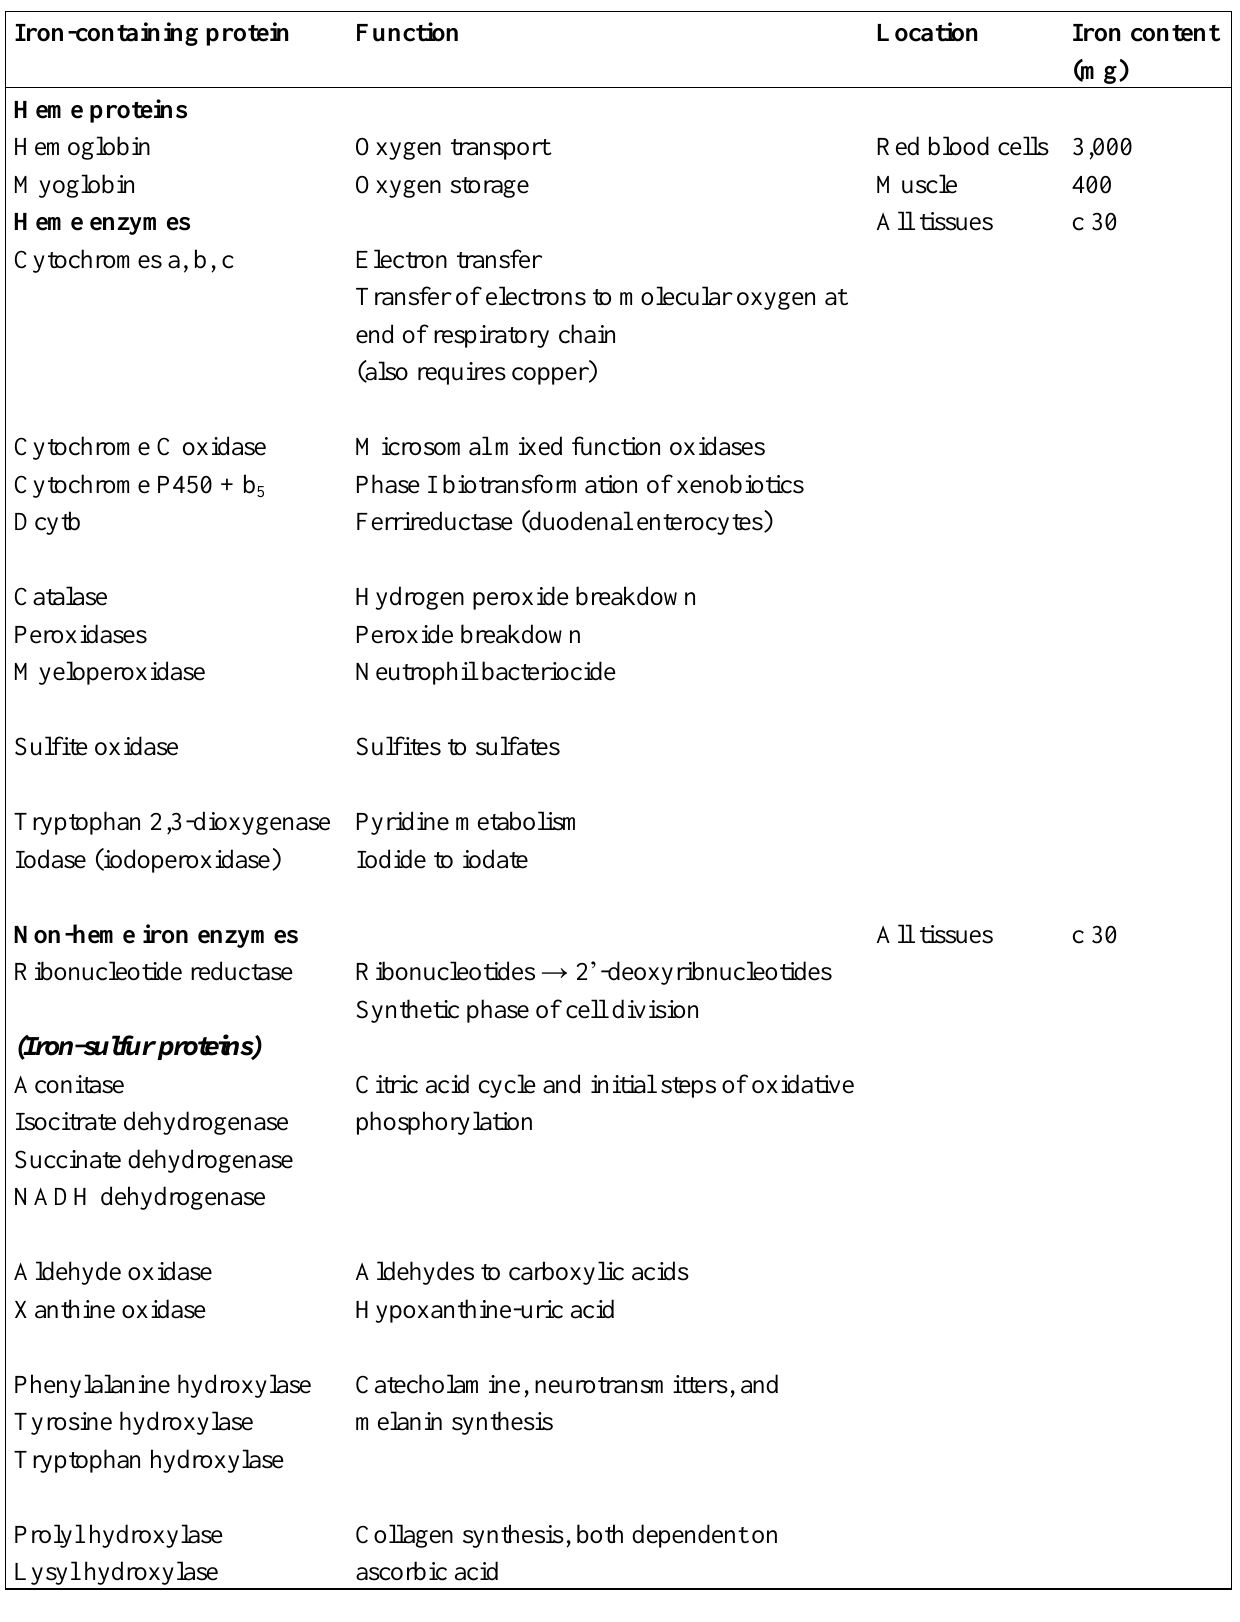
Table 1. Examples of functional iron-containing proteins in the body (75 kg